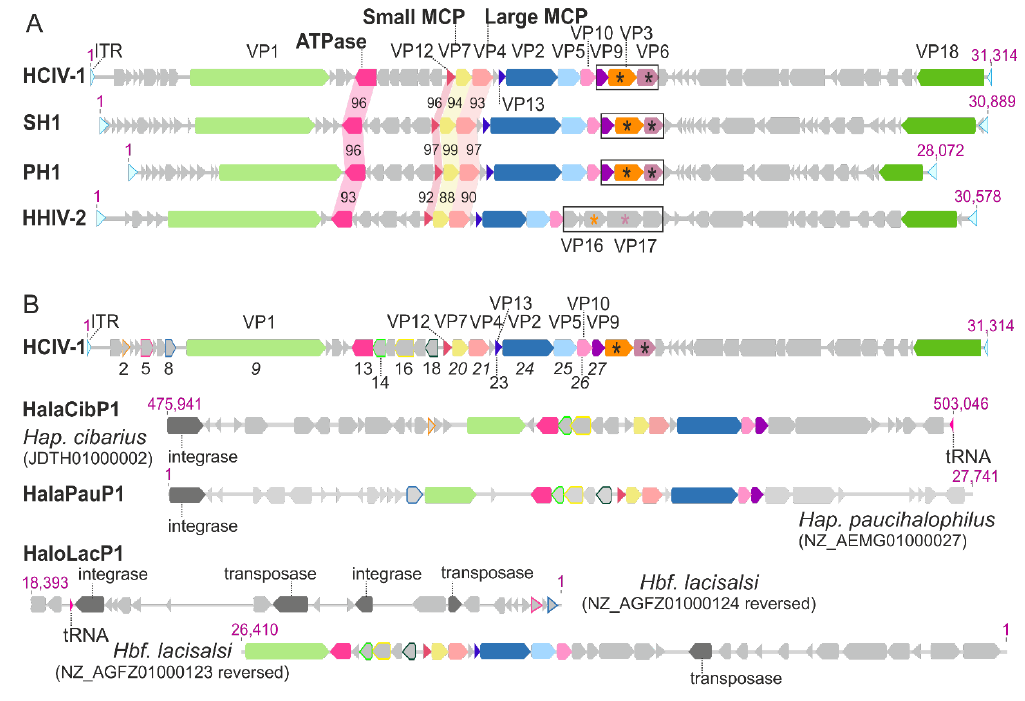
Figure 2. ( A ) Genomes of alphasphaerolipoviruses and ( B ) comparison of HCIV-1 genome with related putative proviral regions in archaeal chromosomes. ( A , B ) Grey arrows: open reading frames (ORFs)/genes. Coloured arrows: homologous genes coding for structural proteins. Light blue arrows: inverted terminal repeats (ITR). Virus ORFs or gene products are noted above the coding regions. The nomenclature for the virion proteins (VPs) is consistent in all four viruses except that the putative spike proteins (marked with an asterisk) of HHIV-2 (VP16 and VP17) correspond to VP3 and VP6 in the other viruses. The genomic regions including the genes encoding putative spike complex proteins are bordered with black lines. ( A ) Pairwise amino acid similarities (%) between the major membrane proteins (VP12), major capsid proteins (MCPs), or putative packaging ATPases are shown in between the genomes; ( B ) Designated ORFs/genes: HCIV-1 ORFs/genes with similarity to putative proviral sequences. Coloured arrows and coloured frames: similar structural proteins and putative proteins, respectively. Integrase and transposase encoding genes, as well as tRNA genes, are indicated in the putative proviruses.